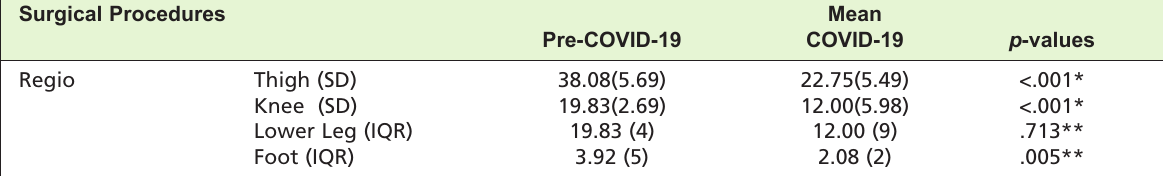
Table III: Total surgical procedure patients in pre-COVID-19 and COVID-19 period by region Surgical Procedures